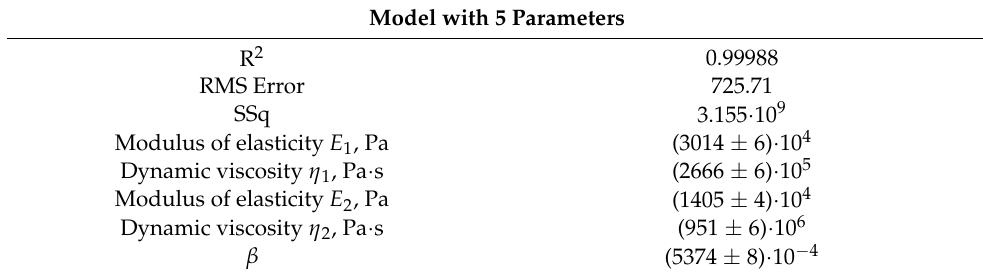
Table 5. Values of parameters in a generalized Maxwell model described with Equation (4) for unaged asphalt binder with 4.5%